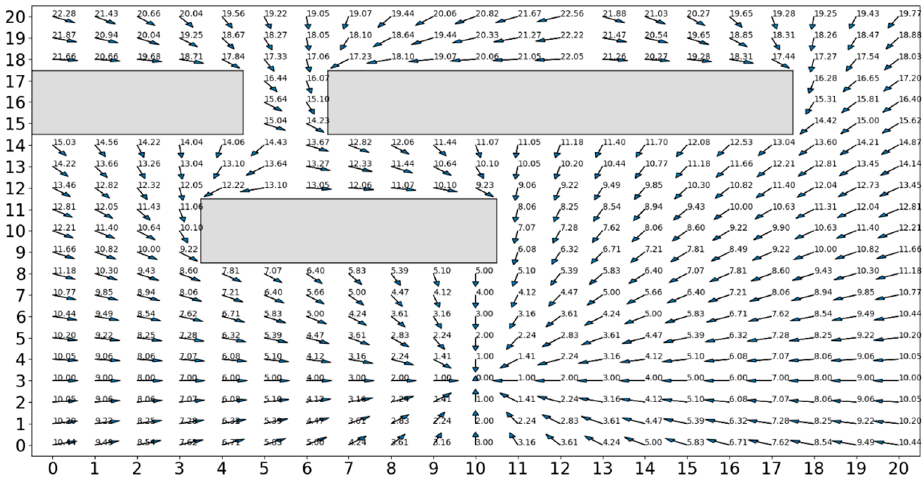
Figure 9. Shortest distance (the number before each arrow) and optimal moving vector (each arrow) fields of the map (x, y axes: indices of cells).